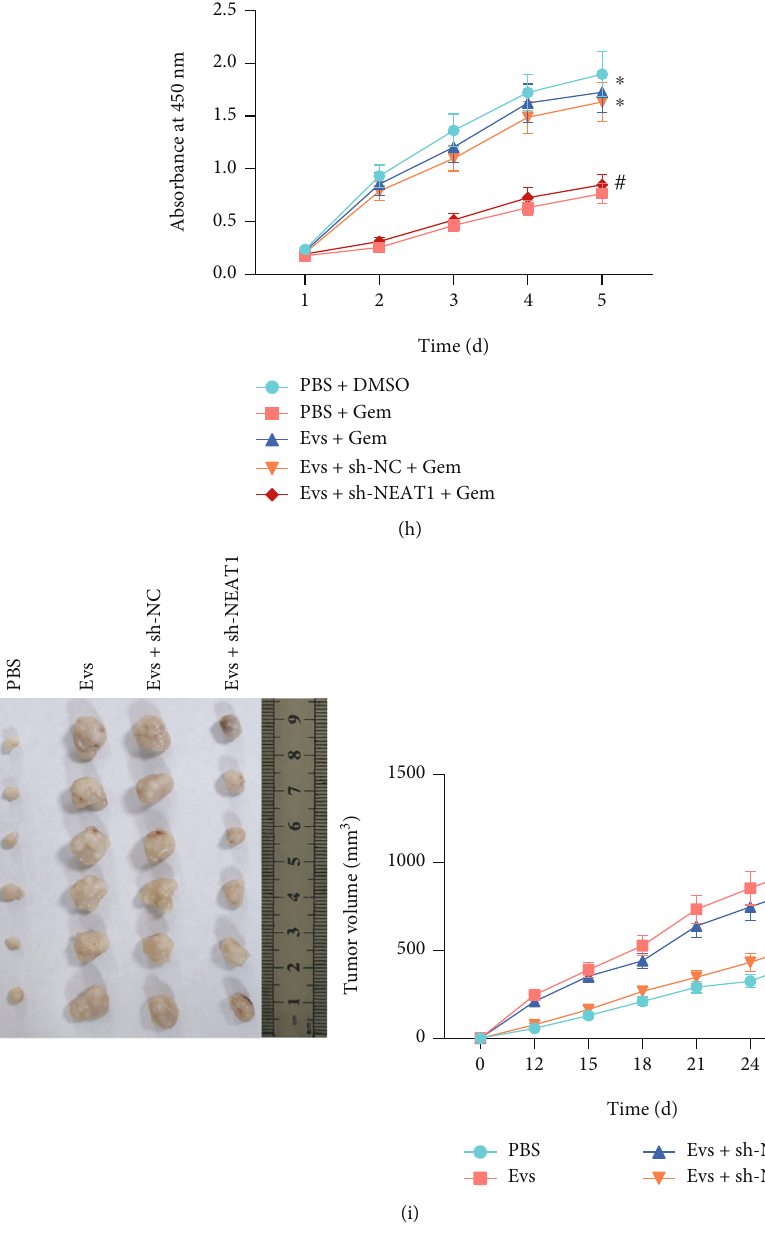
Figure 3: E ff ects of NEAT1 shuttled by ADSC-derived EVs on the biological properties of PCa cells. (a) Silencing e ffi ciency of sh-NEAT1 in ADSCs detected by RT-qPCR. (b) NEAT1 expression in EVs from ADSCs transduced with sh-NEAT1-1 determined by RT-qPCR. (c) NEAT1 expression in SW1990 cells cocultured with EVs from sh-NEAT1-treated ADSCs measured by RT-qPCR. (d) The expression of stemness genes (CD33, OCT-4, NANOG, and CD90) in SW1990 cells cocultured with EVs from sh-NEAT1-treated ADSCs measured by RT-qPCR. (e) Clonogenic potential of SW1990 cells cocultured with EVs from sh-NEAT1-treated ADSCs detected by colony formation assay. (f) Migration of SW1990 cells cocultured with EVs from sh-NEAT1-treated ADSCs detected by Transwell assay. (g) Expression of EMT-related genes (E-cadherin, vimentin, and fi bronectin) of SW1990 cells cocultured with EVs from sh-NEAT1-treated ADSCs measured by RT-qPCR. (h) Resistance of SW1990 cells cocultured with EVs from sh-NEAT1-treated ADSCs to gemcitabine detected by MTS assay. (i) Tumorigenicity of SW1990 cells in mice injected with SW1990 cells cocultured with EVs from sh-NEAT1-treated ADSCs ( n = 6 ). ∗ p < 0 : 05 vs. SW1990 cells transduced with sh-NC, SW1990 cells treated with PBS, or mice injected with SW1990 cells treated with PBS+DMSO or PBS+Gem; # p < 0 : 05 vs. SW1990 cells cocultured with EVs from ADSCs transduced with sh-NC or mice injected with SW1990 cells treated with EVs+sh-NC+Gem. All data were presented as mean ± standard deviation. Comparisons of data between two groups were analyzed by unpaired t -test, and comparisons of data among multiple groups were tested by one-way analysis of variance (ANOVA), followed by Tukey ’ s post hoc test. Data at di ff erent time points were analyzed by repeated measurement ANOVA, followed by Tukey ’ s post hoc test. Cell experiments were independently repeated three